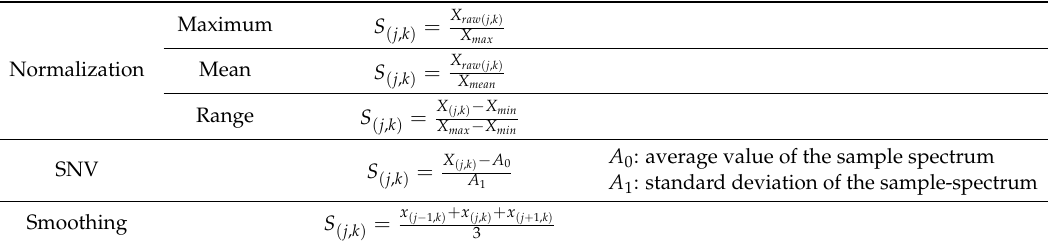
Table 1. Pretreatment methods and equations.